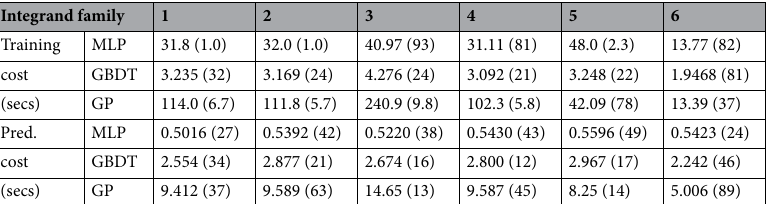
5 Table 2. Wallclock time (s) spent for training (upper) and prediction on 10 random samples (lower) for different ML algorithms with the integrand parameters of N ≈ 5000 , D = 8 , and || c || 1 = 3.0 . N train = 2500 for integrand families 1, 2, 4, and 5, N train = 3500 for integrand family 4, and N train = 1500 for integrand family 6. The results are averaged over 36 runs of random integrands as described in “Numerical experiments” section. The numbers in the parentheses are the standard deviation of the mean. The wallclock time is measured using a single core of an Intel Xeon E5-2695 v4 processor at